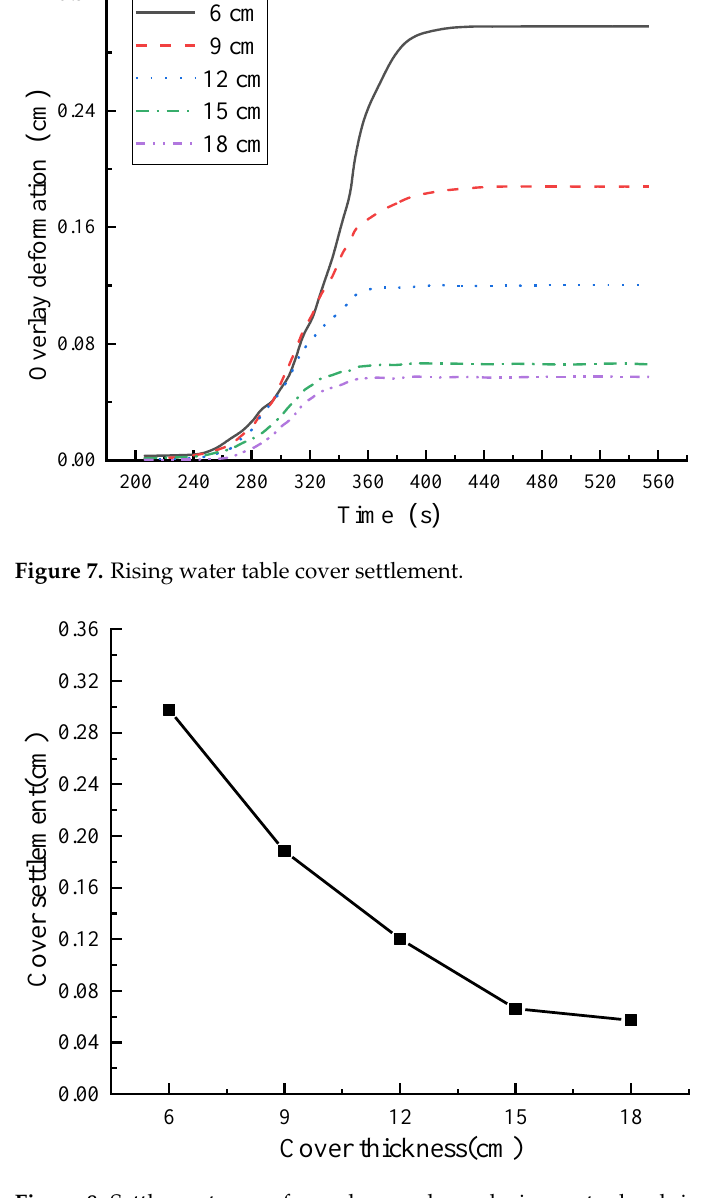
Figure 8. Settlement curve for each cover layer during water level rise.